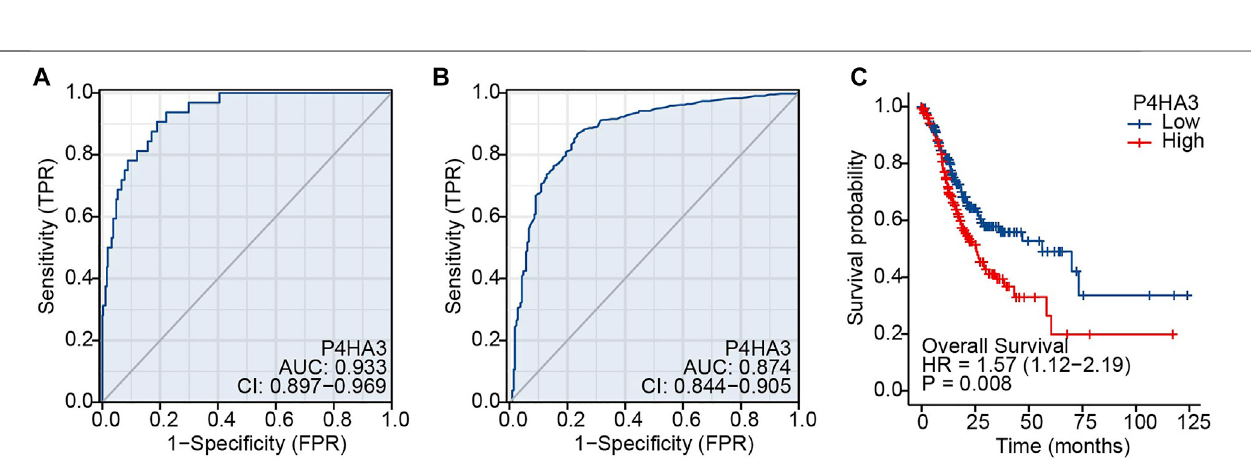
FIGURE 4 | ROC and Kaplan-Meier survival curves. (A) ROC curve for P4HA3 based on data from TCGA; (B) ROC curve for P4HA3 using data from non- cancerous samples from GTEx combined para carcinoma tissues and GC samples; (C) Higher levels of P4HA3 expression tended to be associated with worse outcomes (OS) for GC patients. Abbreviations: ROC, receiver operating characteristic; GTEx, Genotype-Tissue Expression Project.